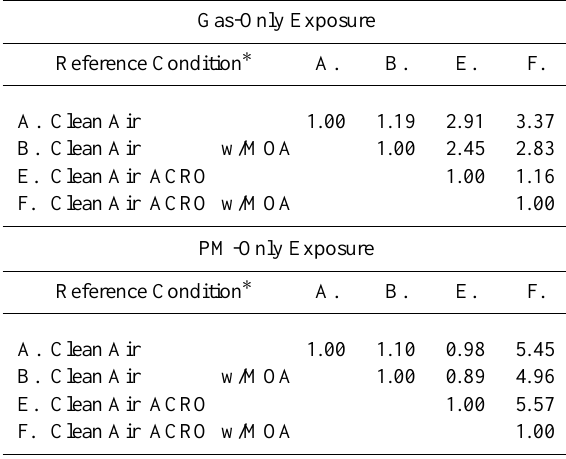
Table 5. Ratios of measured cellular damage (LDH) for in vitro human lung cell exposures to ACRO mixtures, (Table 1 and Fig.